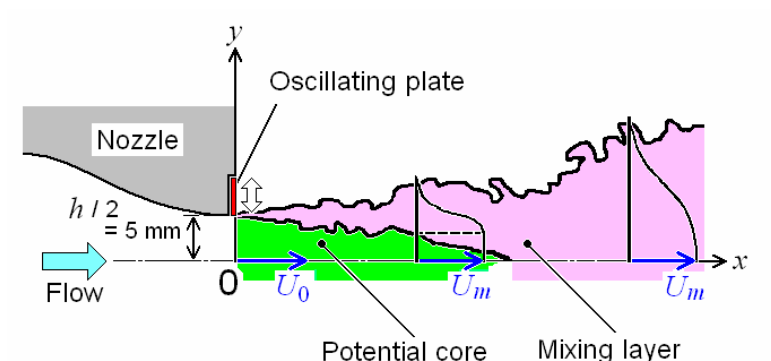
Fig. 1 Schematic diagram of two-dimensional mixing layer and coordinate